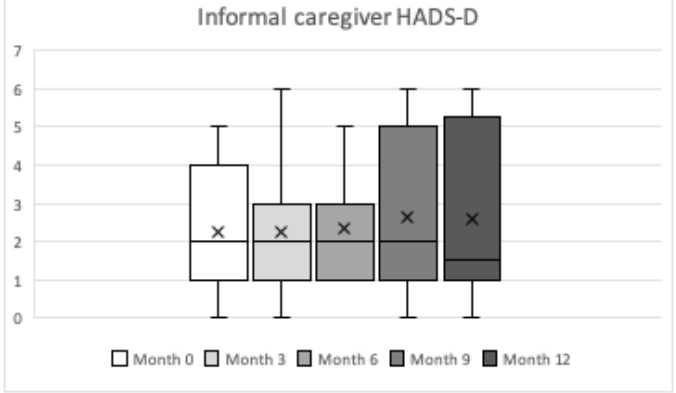
Figure 6. Informal caregivers’Hospital Anxiety and Depression Scale-D during the year observation period (minimum, quartile 1, median, quartile 3, maximum).